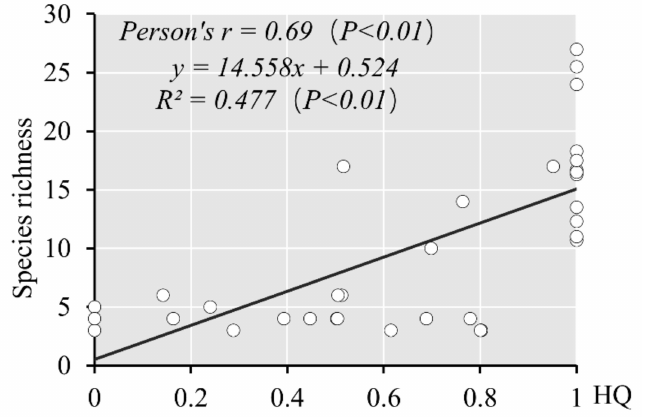
Figure 2. The validation of habitat quality based on species richness.